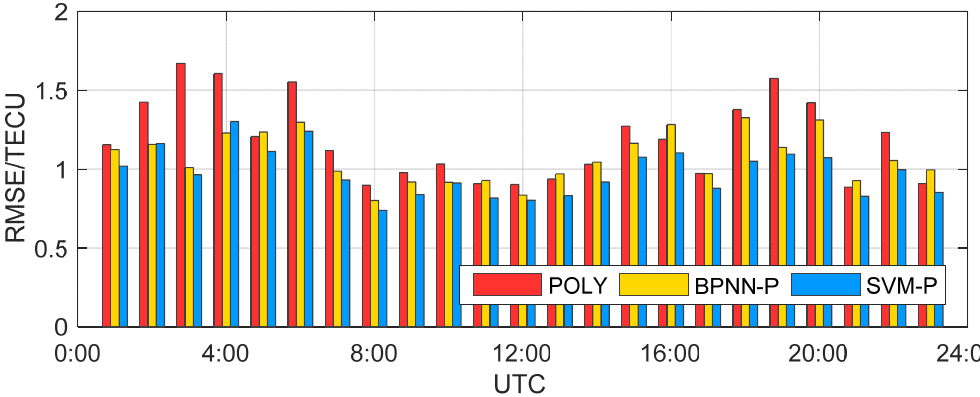
Figure 8. Model root mean square errors (RMSEs) of polynomial (POLY), back propagation neural network polynomial (BPNN-P), and Support Vector Machine polynomial (SVM-P) at 23 hourly moments. Table 2. Root mean square errors (RMSEs) of three ionosphere models in different moments(TECU).